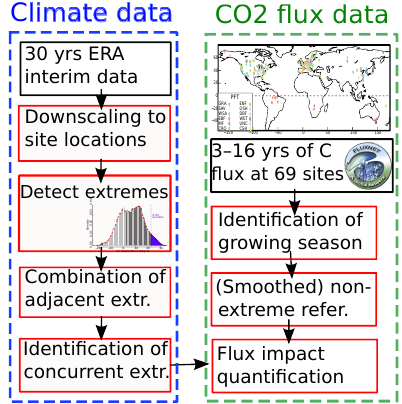
Figure 1. Comparison of the gross primary productivity (GPP) reductions during the 2003 European heat wave for several FLUXNET sites. Ciais et al. (2005) quantified this reduction by comparing the 2003 fluxes to the previous year, whereas we are able to use all available site years as a baseline.